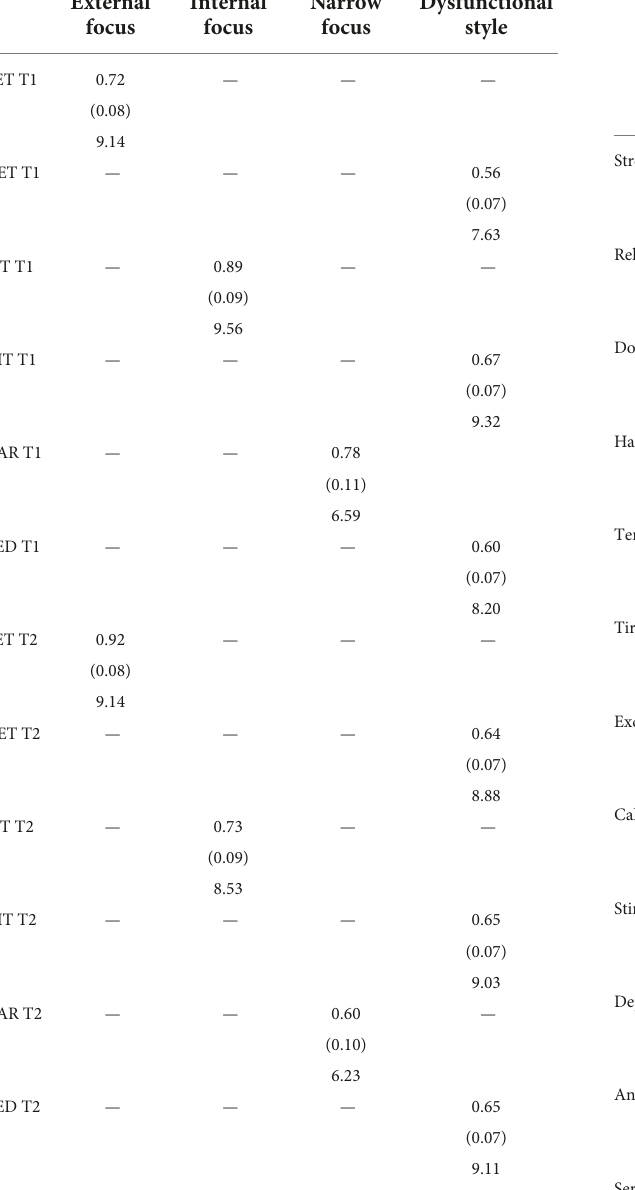
TABLE 3 Lambda-X matrix of the factor loadings for the four-factor model of the emotions